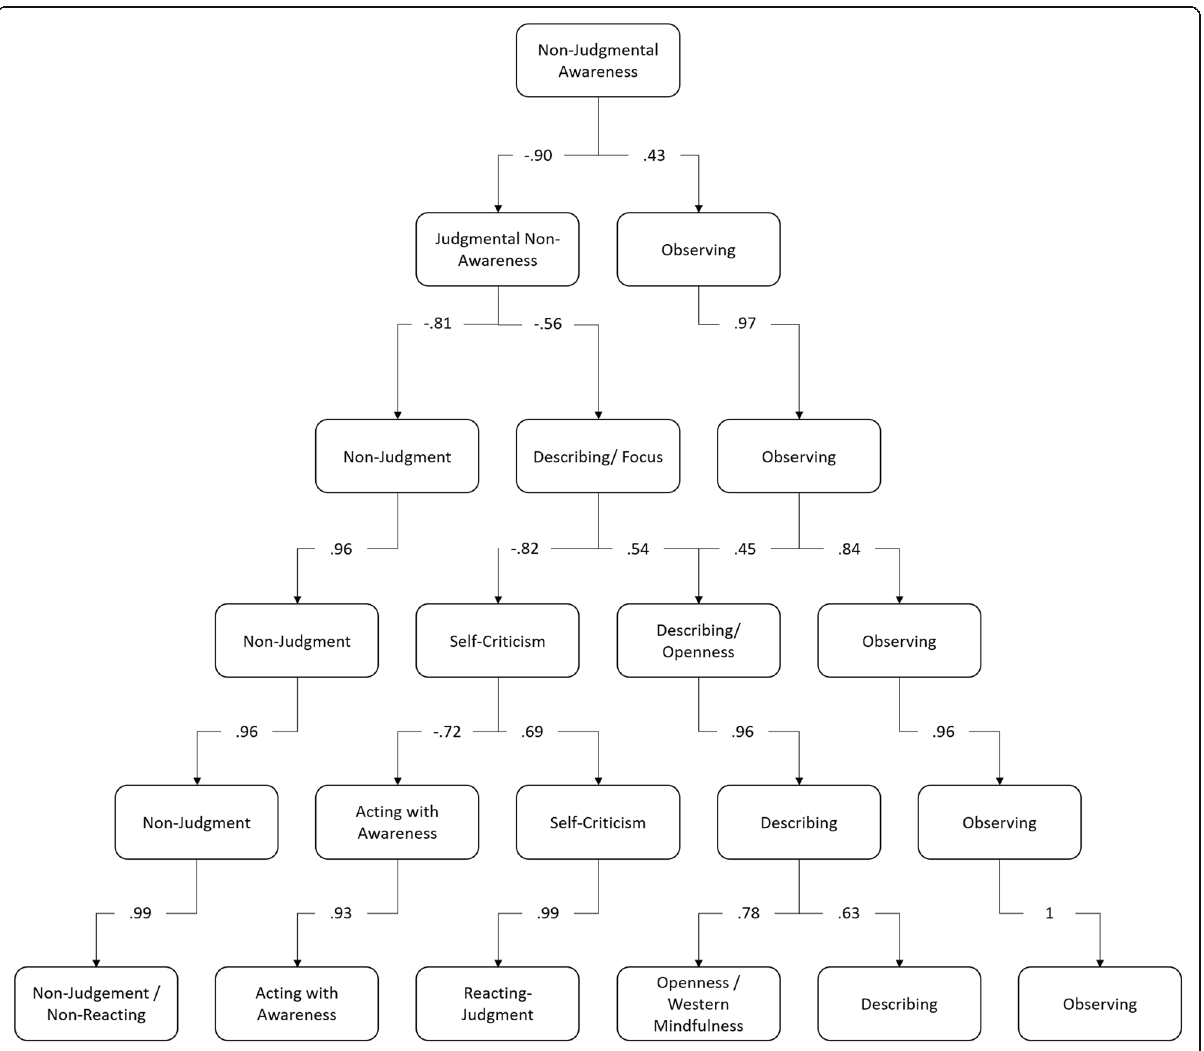
Fig. 1 Unfolding structure of the six-component solution. Each component scores are correlated with component scores at the prior level. We show correlations r ≥